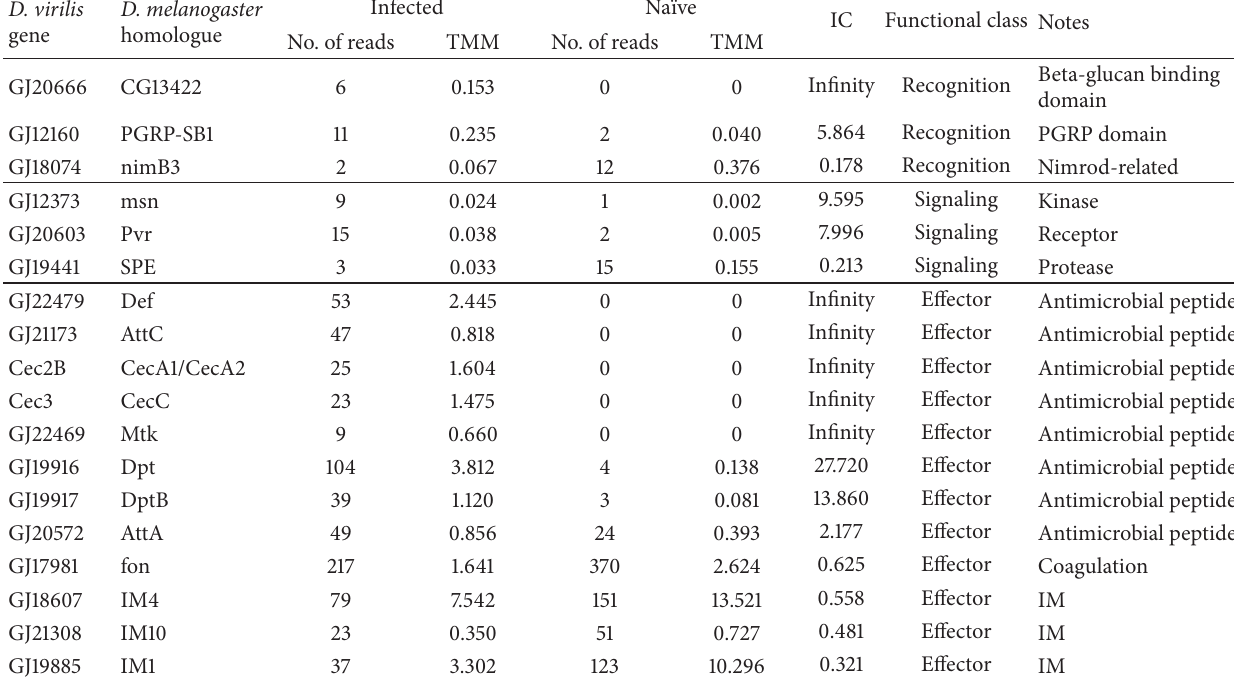
Table 2: Number of reads, trimmed mean of M value (TMM), and induction coefficient (IC) for recognition, signaling, and effector class immune genes showing significant changes in expression level by fungal infection in D. virilis . D.